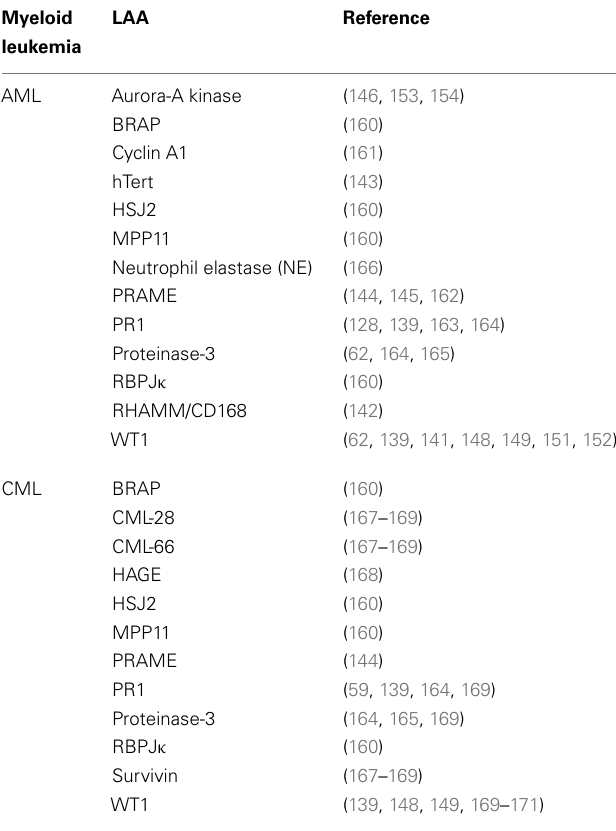
Table 1 | Leukemia-associated antigens (LAAs) in myeloid